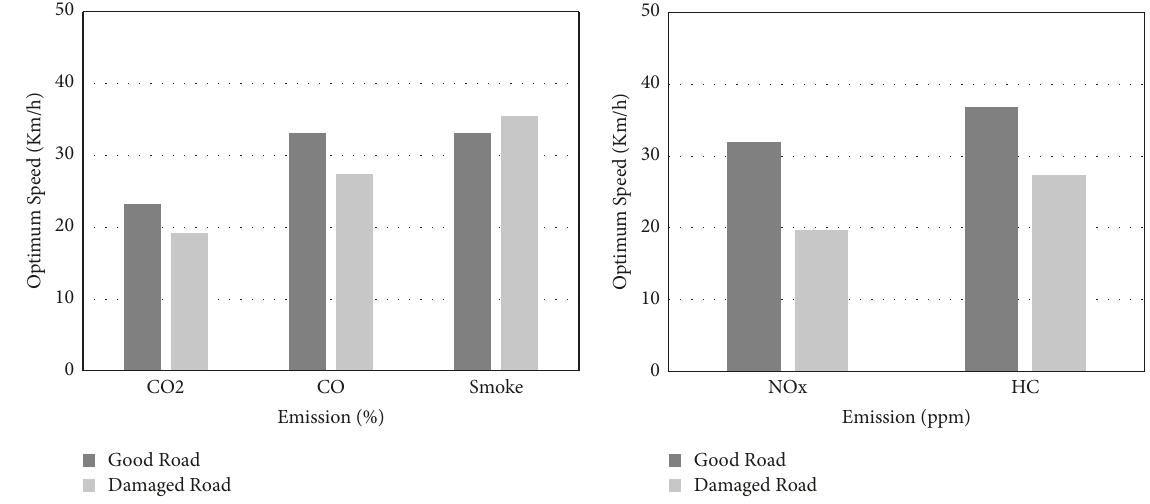
Figure 7: Optimum speed driving cycle